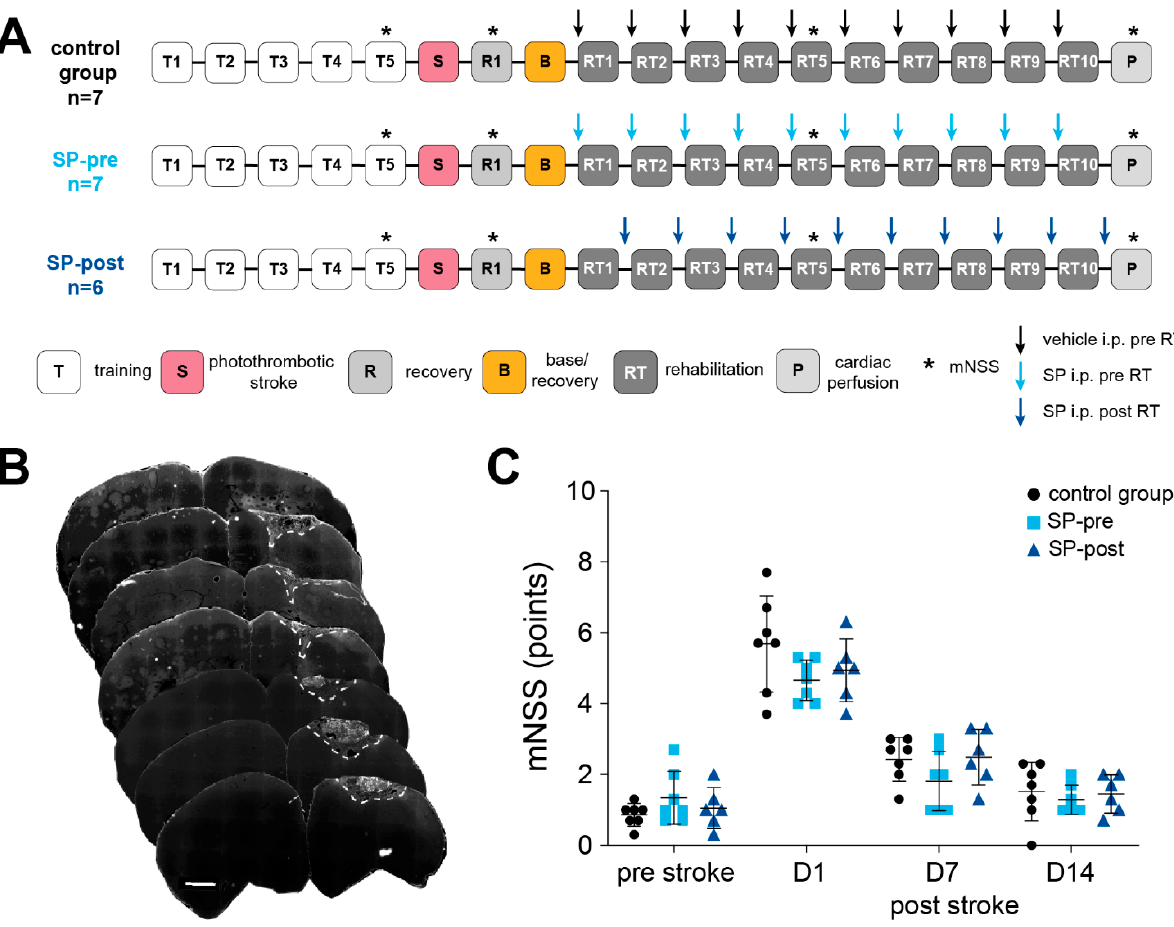
Figure 1. ( A ) Schematic depiction of the experimental timeline. ( B ) Series of microscopy images (10× magnification) displaying a representative photothrombotic ischemic stroke affecting the primary motor cortex (M1), identified by Fluorojade-C staining. ( C ) A similar stroke-related neurological deficit measured by the modified neurological severity score (mNSS) that recovered with time was present in all groups. Scale bar: 500 µm. Data are presented as mean ± SEM.